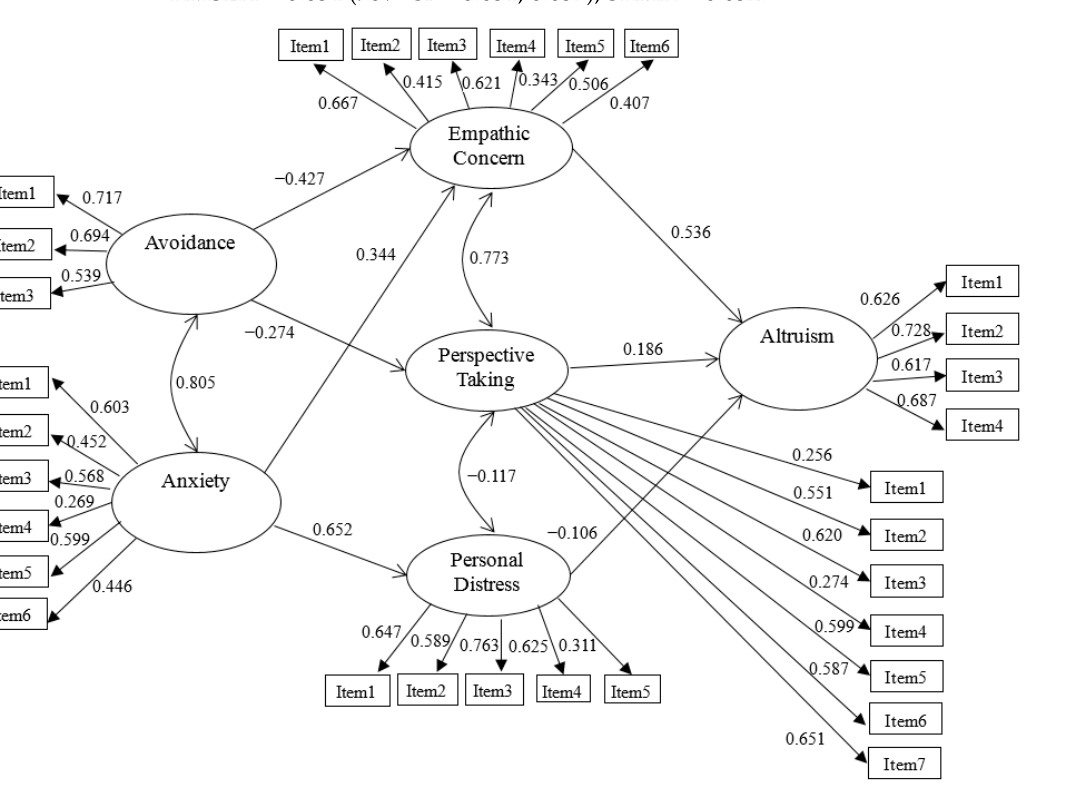
Figure 1. Relations of attachment avoidance and anxiety to altruistic behaviors via empathic concern, perspective taking, and personal distress. Note . Only paths with statistical significance ( p < 0.05) are shown.